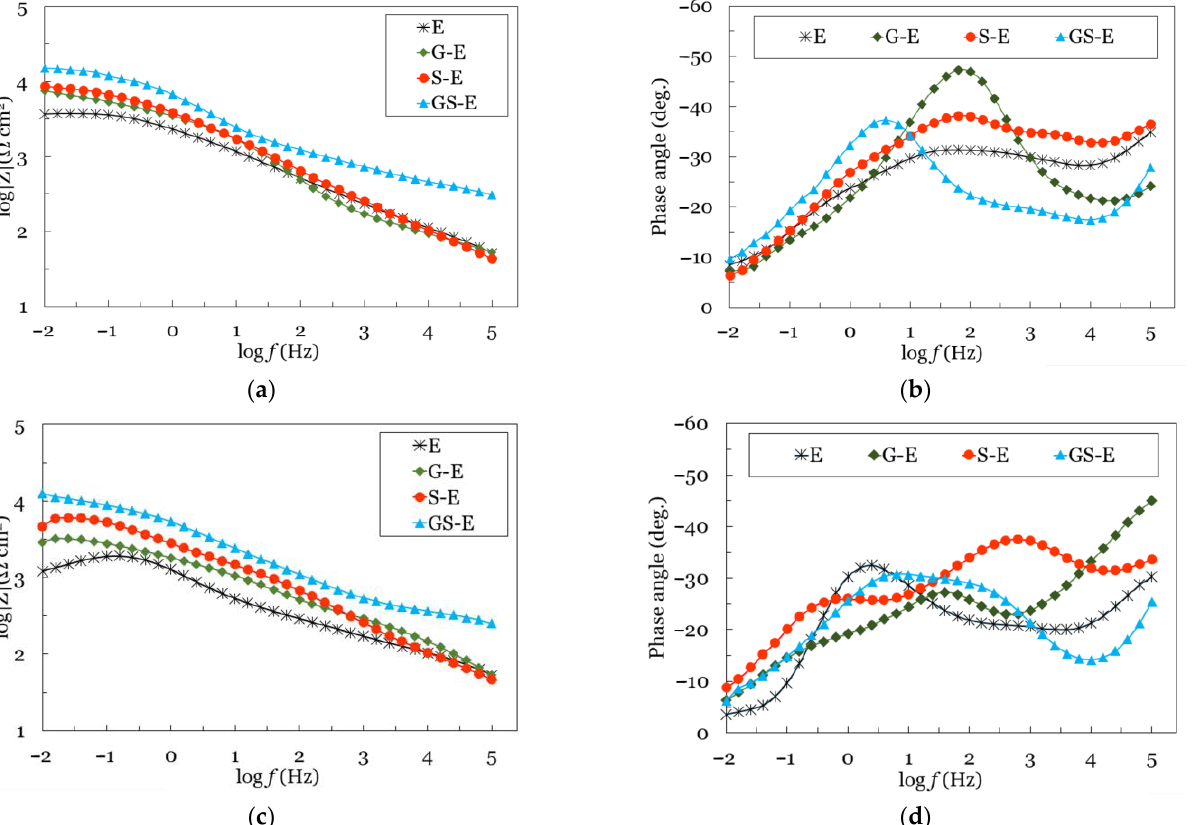
Figure 10. Impedance and phase angle curves of coated rebars ( a , b ) before salt spray exposure and ( c , d ) after salt spray exposure.